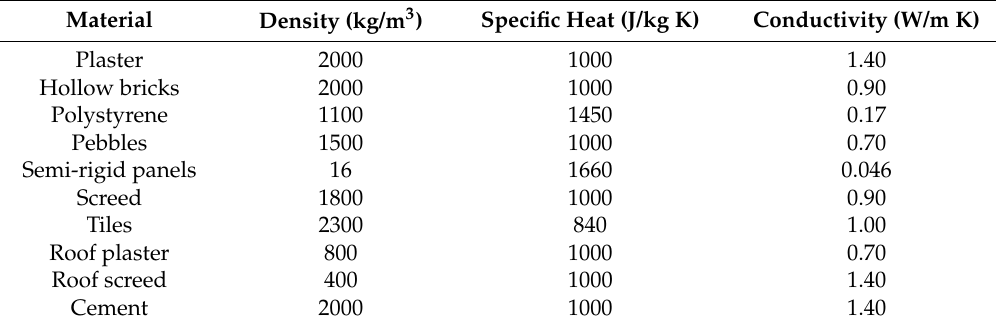
Table 4. Thermo-physical properties of the opaque building envelope